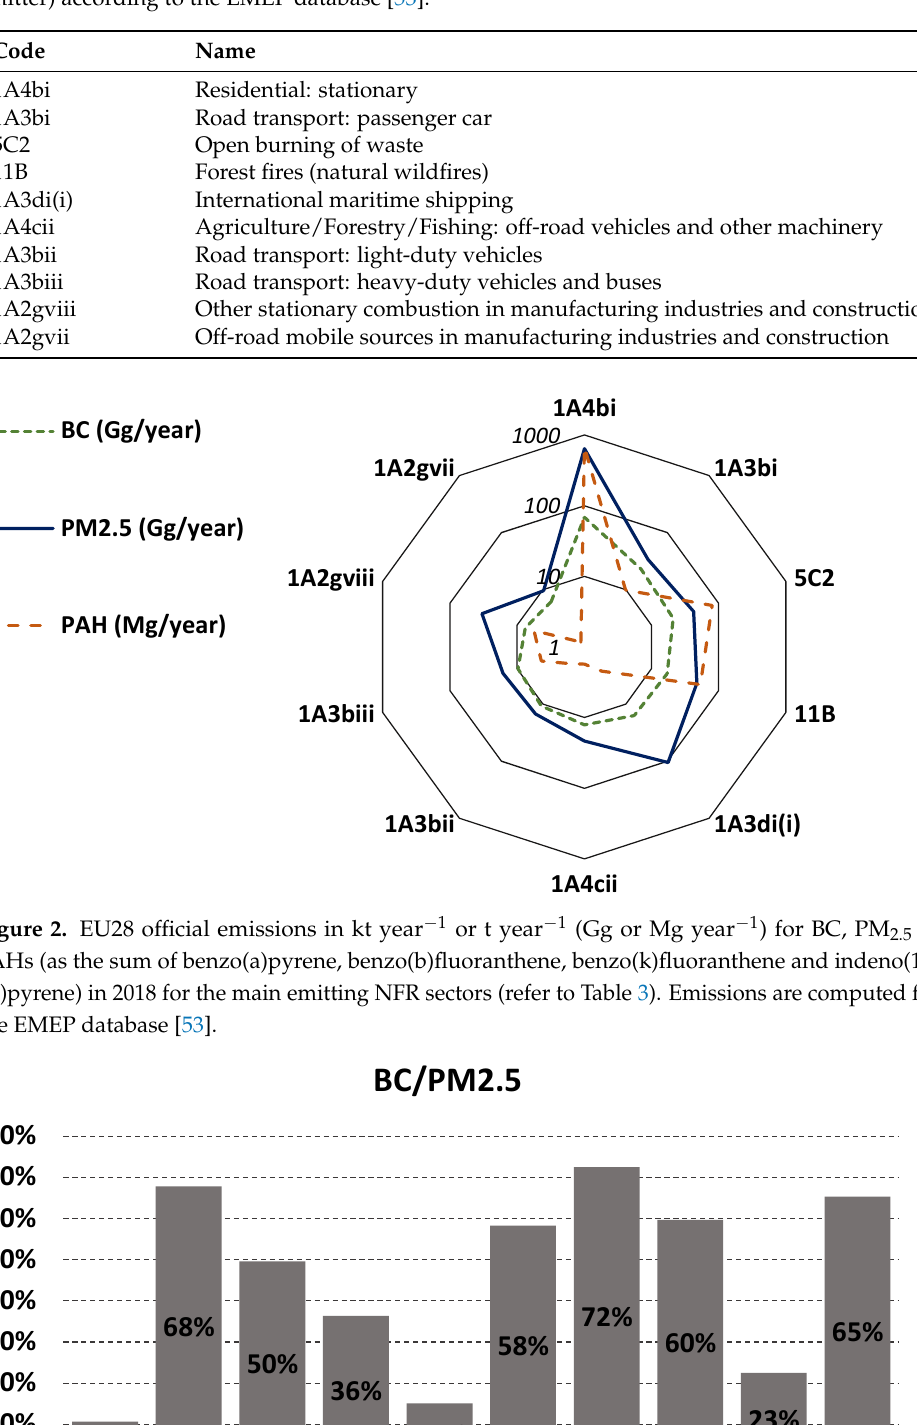
Table 3. Top ten BC-emitting activity sectors in EU28 in 2018 (sorted from the highest to the lowest emitter) according to the EMEP database [53].